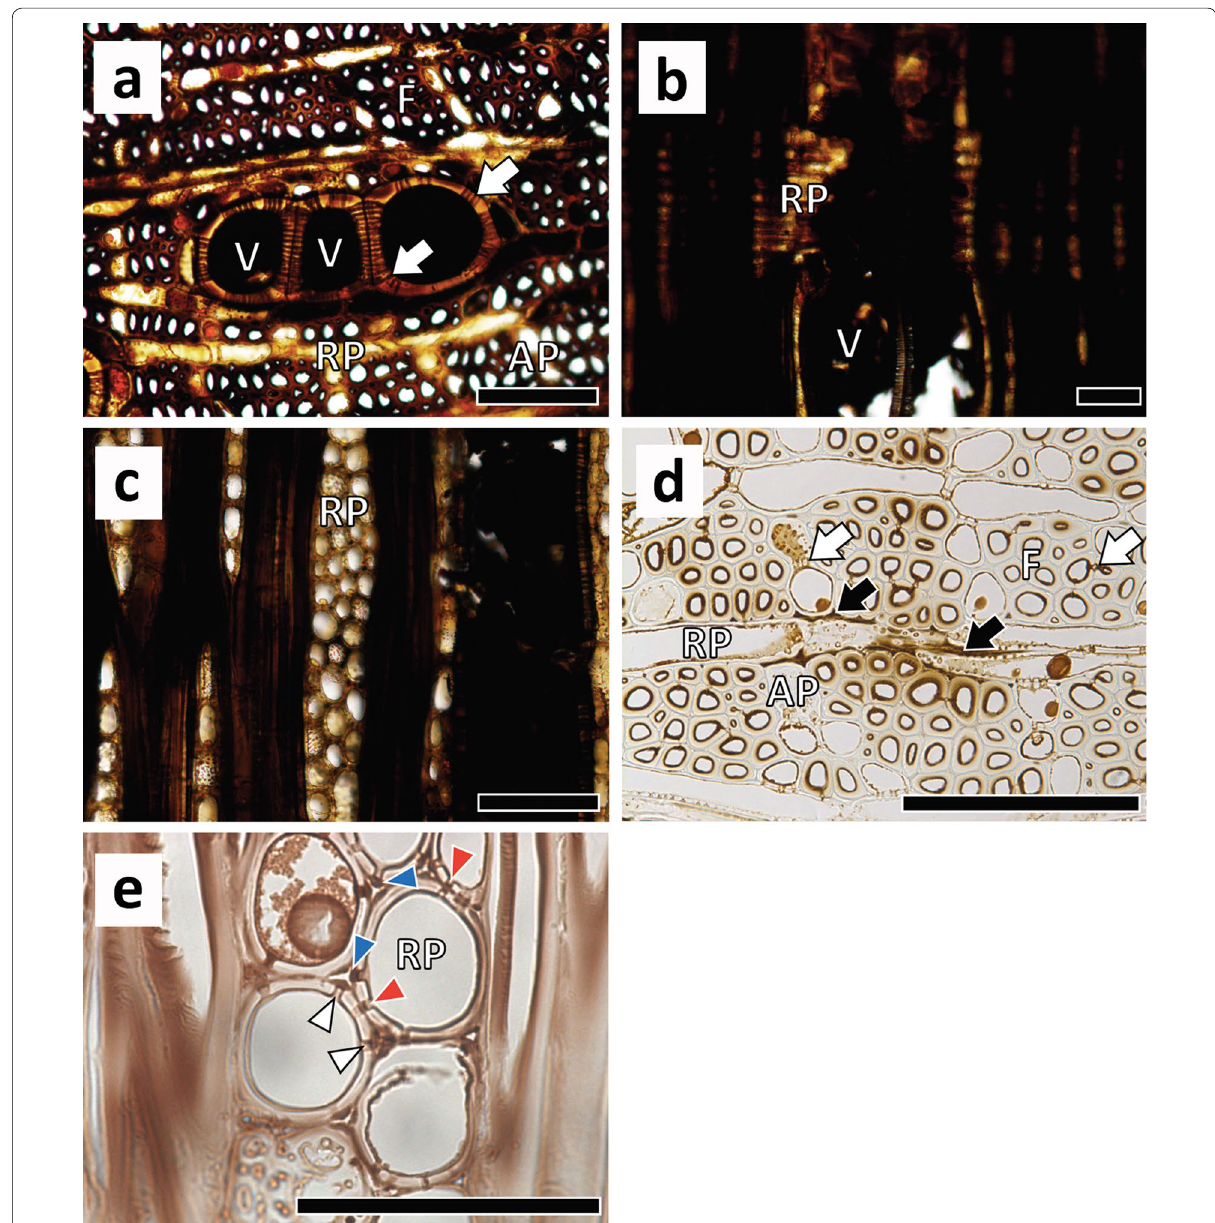
Fig. 4 Light micrographs of transverse ( a , d ), radial ( b ) and tangential ( c , e ) sections of black regions of samples of D . kaki wood. White arrowheads indicate colored substances in blind pits of ray parenchyma cells that faced intercellular spaces. Red arrowheads indicate colored substances in pits between ray parenchyma cells. Blue arrowheads indicate colored substances leaking from blind pits into intercellular spaces. White arrows indicate colored substances in pits. Black arrows indicate colored substances in intercellular spaces. AP: axial parenchyma cell; F: wood fiber; RP: ray parenchyma cell; V: vessel element. Scale bars 100 μm in a – d ; 50 μm in =